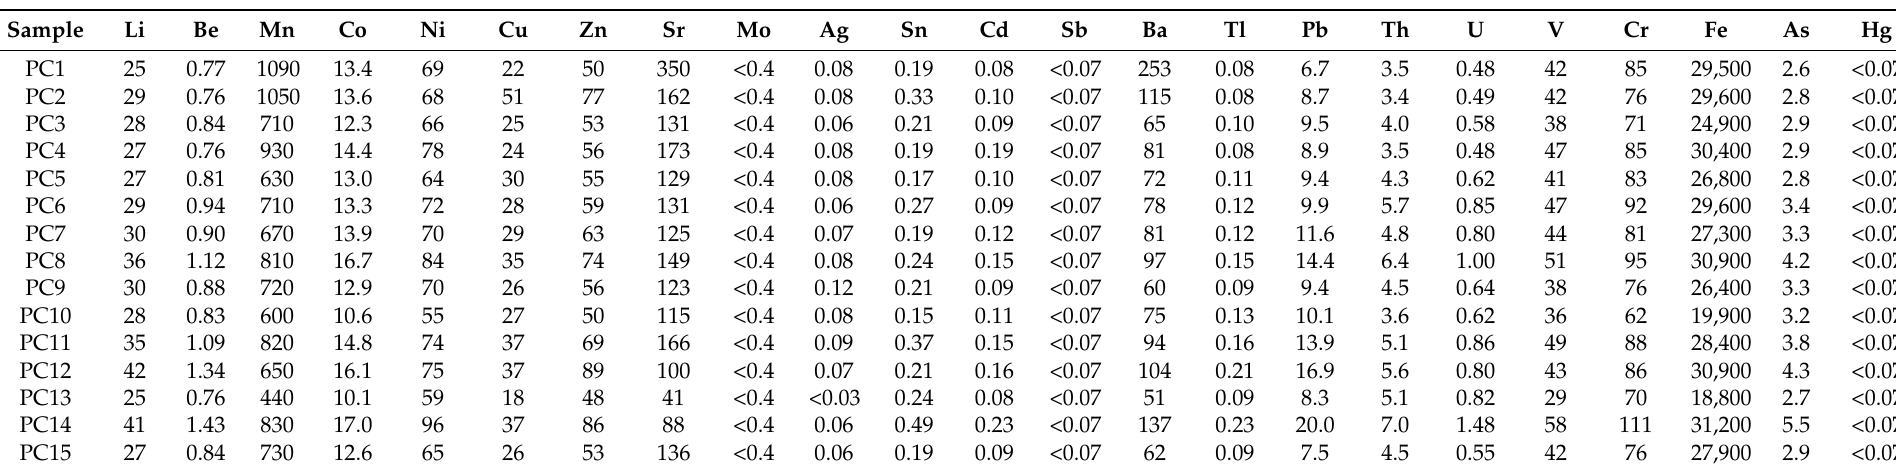
Table 2. Trace elements on Pontecosi lake sediments (mg/kg).